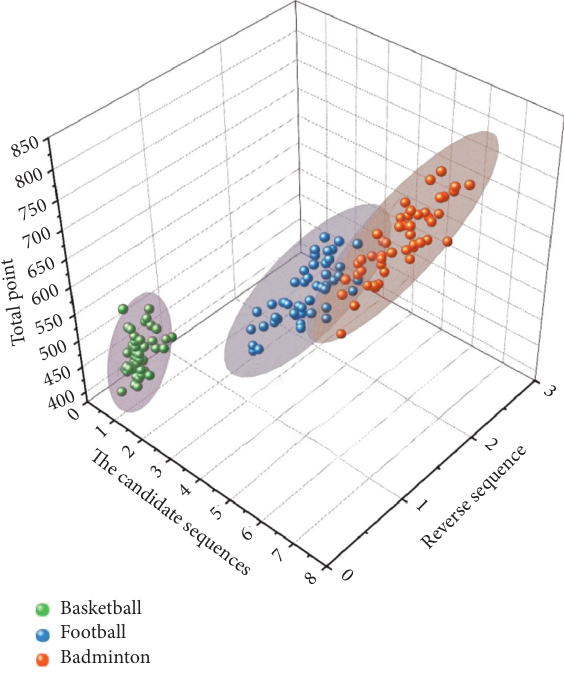
Figure 7: Stochastic simulation method for